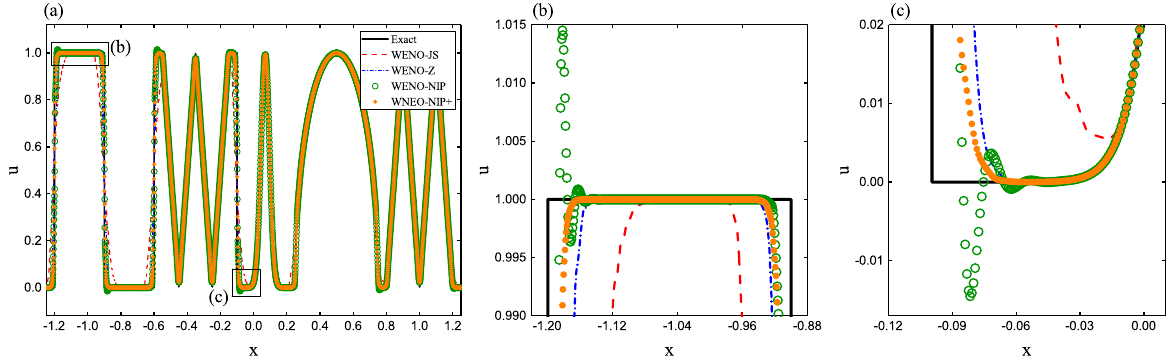
-1.2 -1.0 -0.8 -0.6 -0.4 -0.2 0.0 0.2 0.4 0.6 0.8 1.0 Figure 8. ( a ) Results of the ZWACM linear test with t = 200 (80 cycles) and N = 3200. ( b ) Zoomed-in view of the top of the square wave. ( c ) Zoomed-in view of the concerned region as marked in ( a